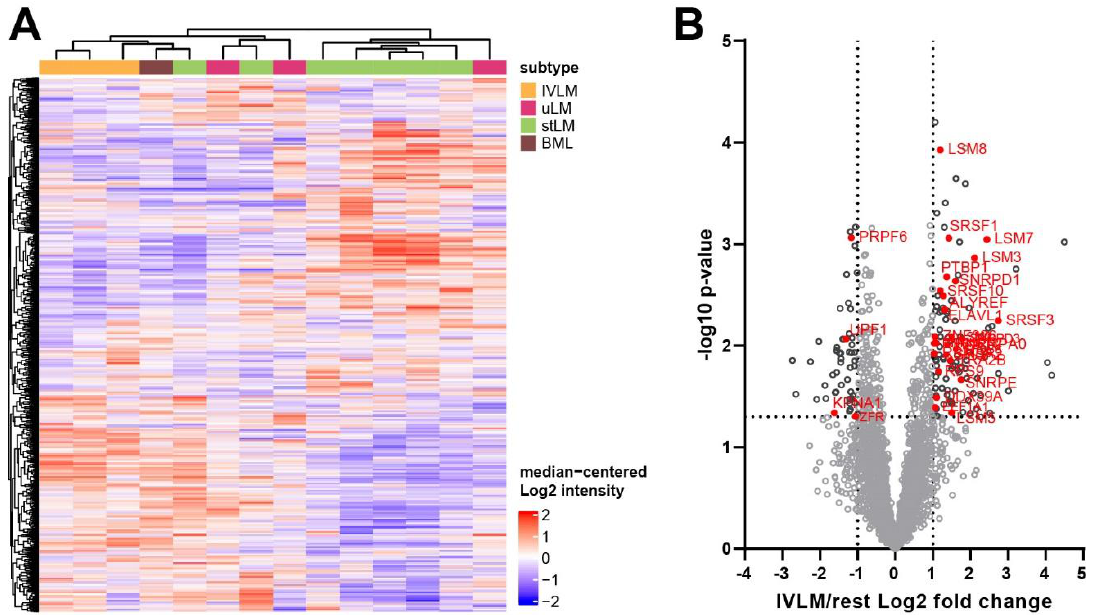
Figure 2. ( A ) Heatmap depicting unsupervised hierarchical clustering of 2473 proteins that were quantified across all samples. The distance measure used for clustering is Pearson’s correlation. The full protein list is provided in Table S1. ( B ) Volcano plot depicting difference in protein expression between IVLM cases and all the other smooth muscle tumours (rest). Splicing factors with significantly different expression levels (>two-fold or <two-fold) are highlighted in red.